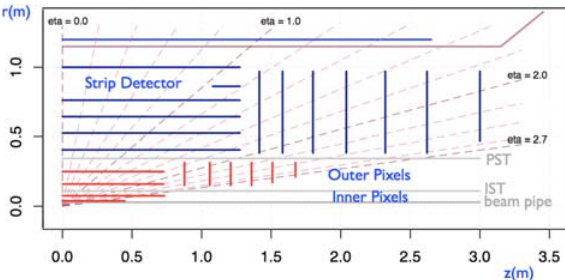
Figure 7. Proposed layout of the Inner Tracker for operations during HL-LHC[9].